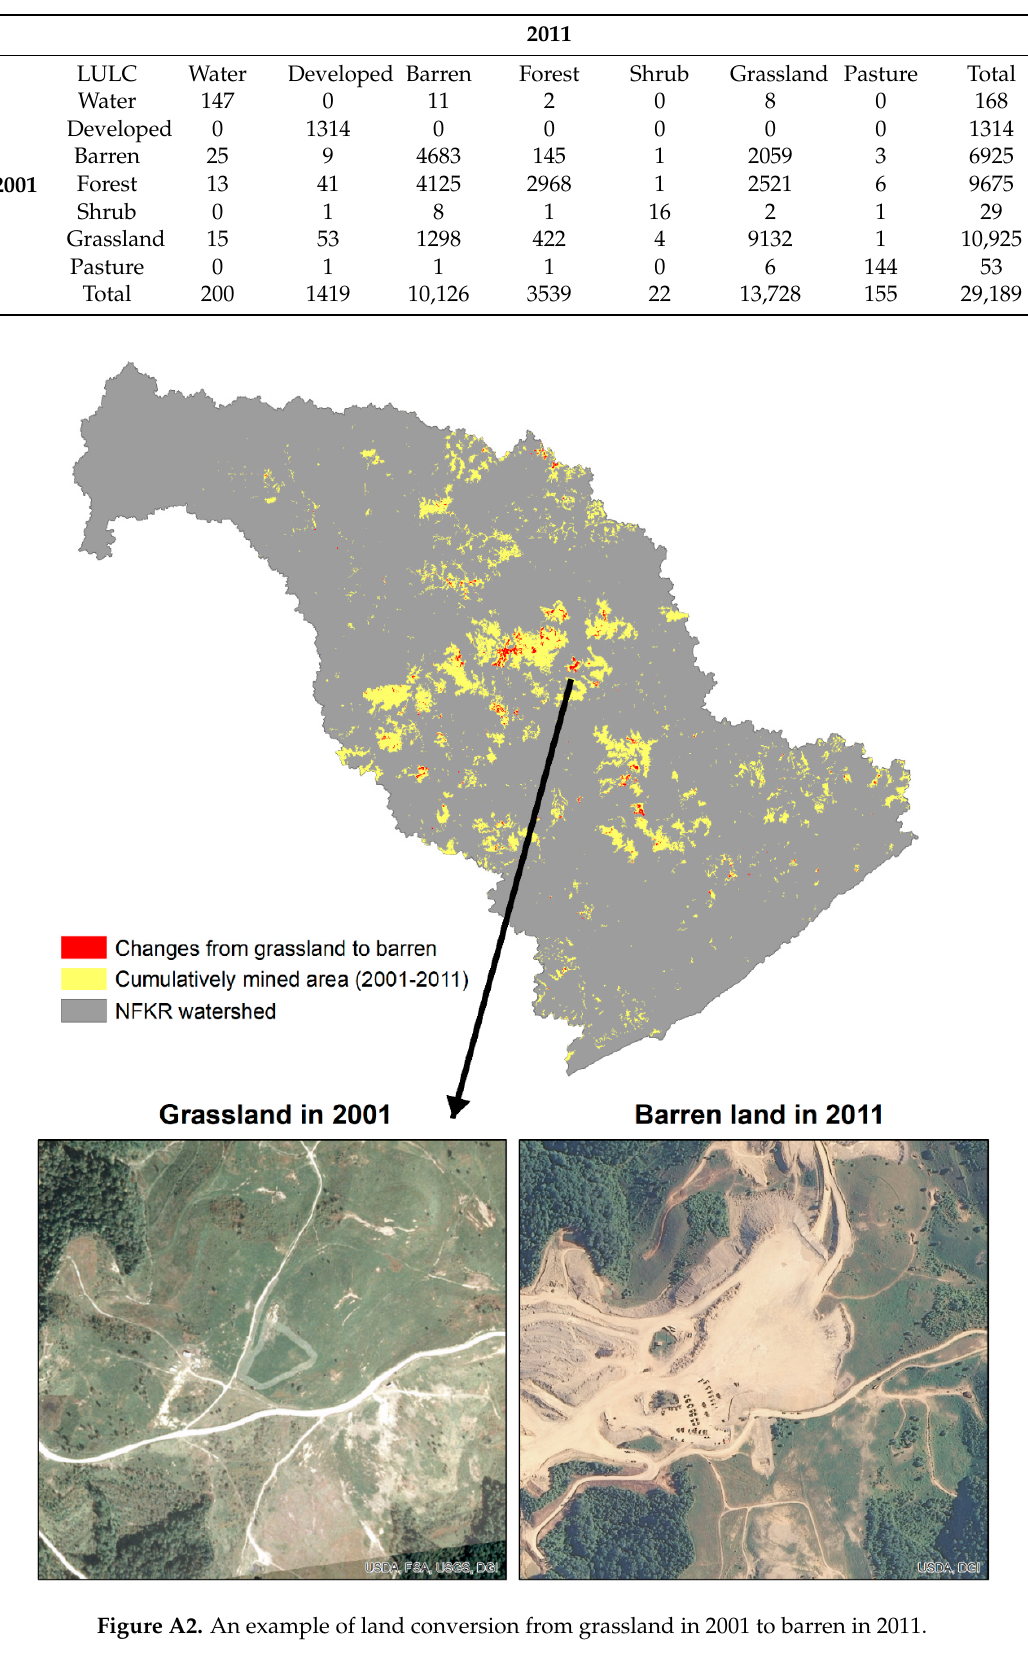
Table A4. Size of area that has experienced transition from one land cover category to another between 2001 and 2011 (unit, hectares) within the mined sites in the NFKR watershed.